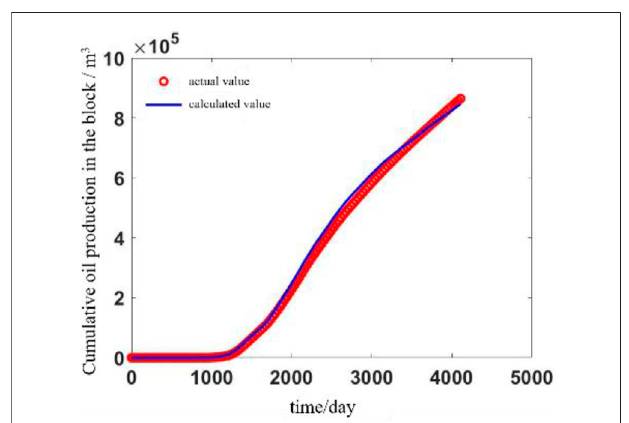
FIGURE 1 | Fitting